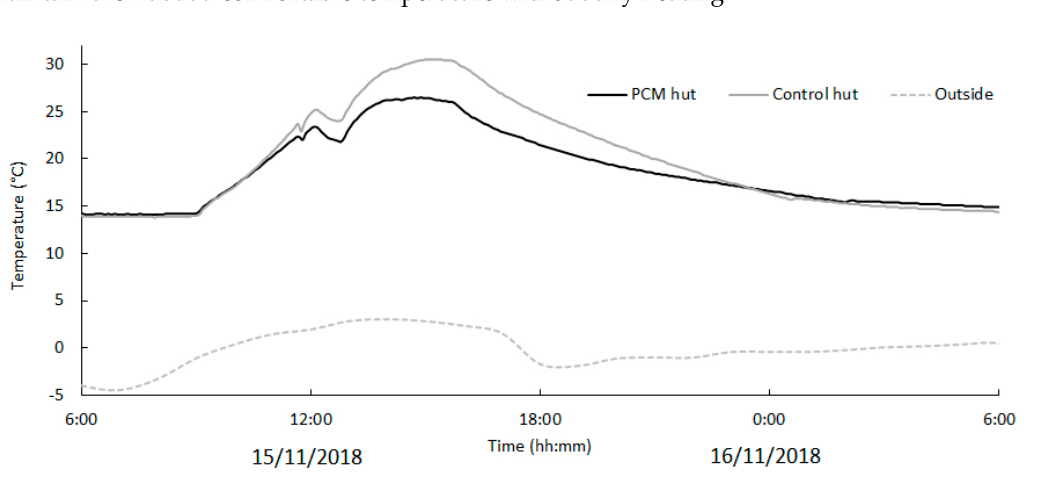
Figure 4. Dry temperature of a sunny winter day, 16 °C setpoint.